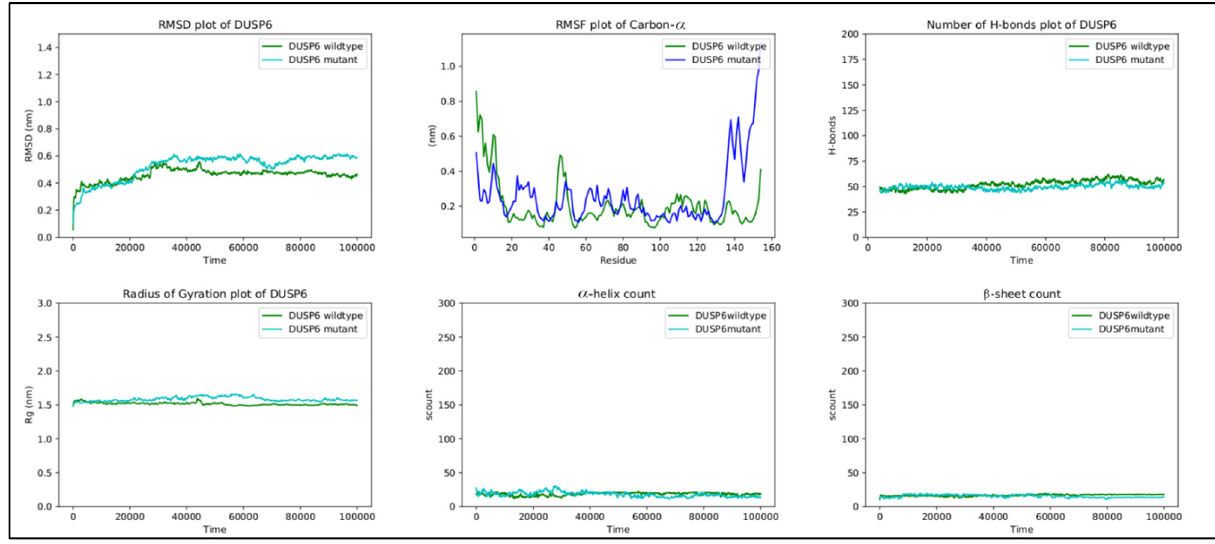
Figure 6. RMSD, RMSF, hydrogen bond count, radius of gyration, and secondary structure count plots of DUSP6.